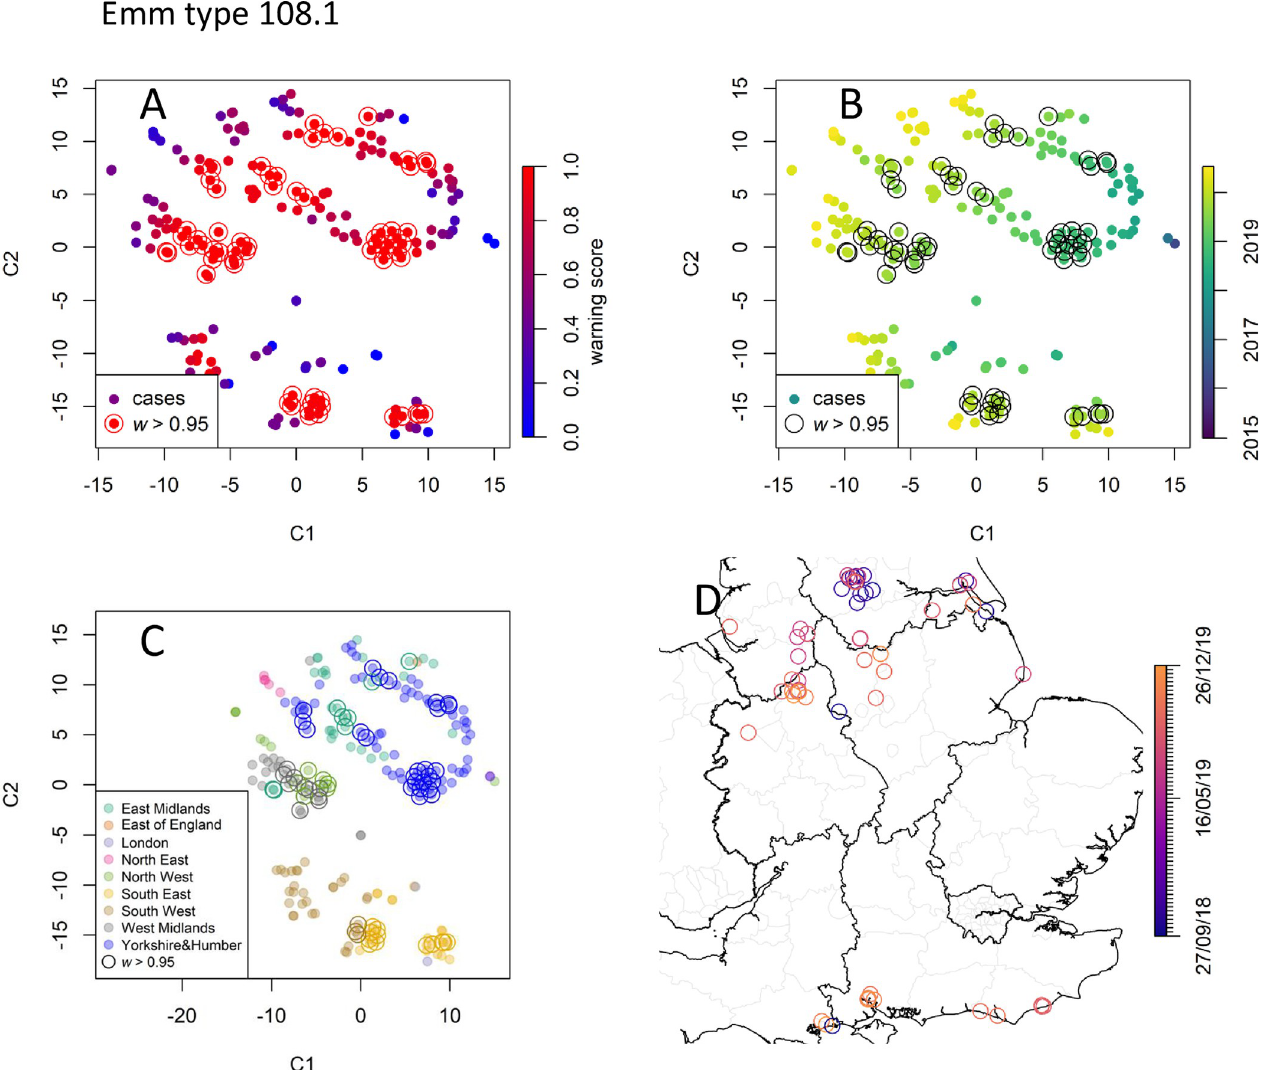
Fig 8. Data point embedding and cluster analysis for emm type 108.0. Keys as in Fig 7. emm 108.0 is a concerning type due to its recent increase in the number of cases. The many cases tagged with high warning scores ( A ) occurred after 2018 ( B ) and are clustered around several geographical locations ( C - D ). Map created with Sf [55] using shapefiles from the GADM database (https://gadm.org/maps/GBR_1.html) and the Ordnance Survey Data Hub (https://